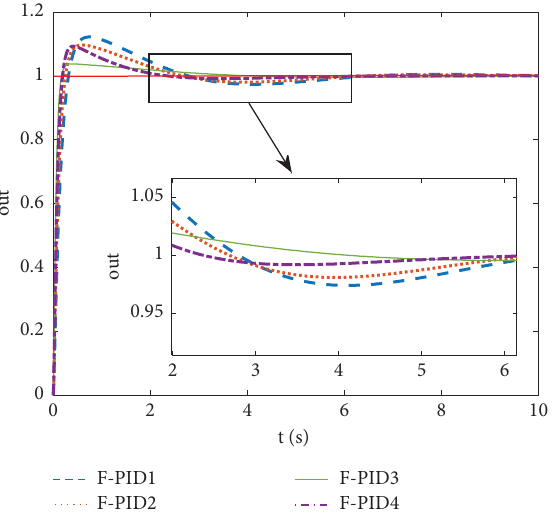
Figure 6: Fuzzy-PID step response curve.